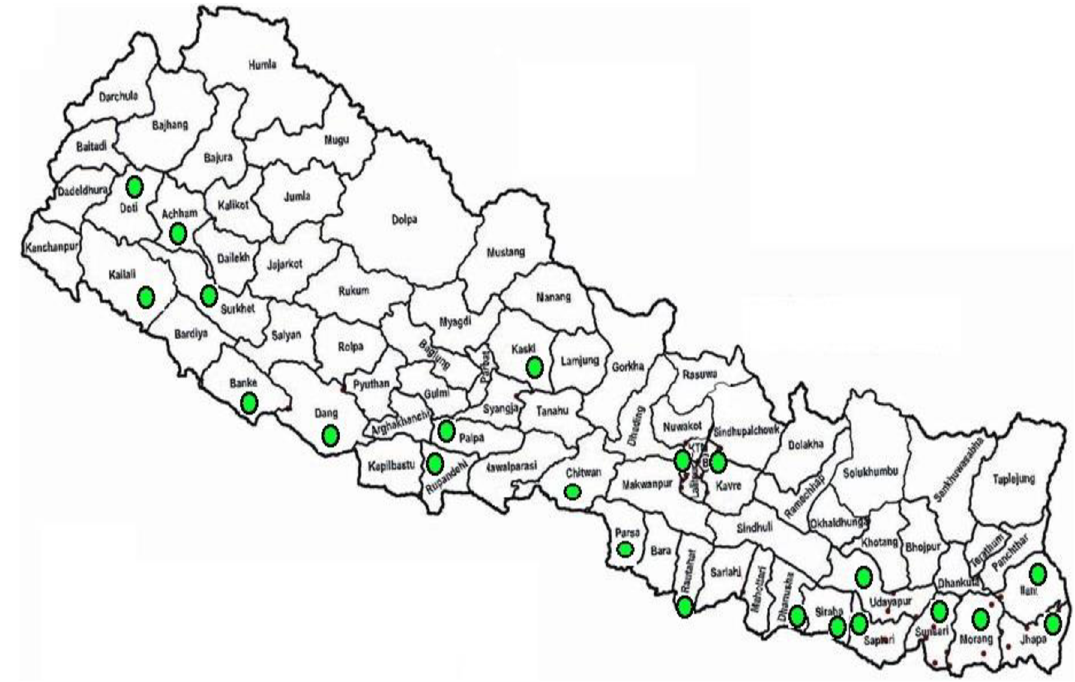
Fig 1. Districts equipped with Gene Xpert MTB/RIF centres in Nepal by